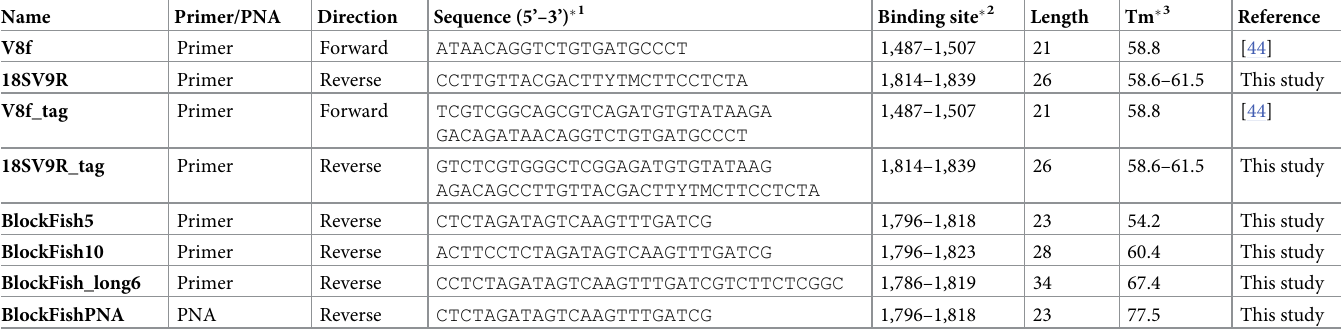
Preparation of fish genomic DNA, PCR condition, and DNA sequencing The dorsal fins or dorsal muscles of the fish samples were cut into sections (approximately 0.1 g each), which were transferred into separate 1.5 ml microcentrifuge tubes (Greiner Bio-One, Kremsmu¨nster, Austria). The genomic DNA of the fish samples was extracted using a DNeasy Plant Mini Kit (Qiagen, Hilden, Germany) according to the manufacturer’s protocol. The con- centration of genomic DNA of each sample was quantified using a Qubit 1 3.0 Fluorometer (Thermo Fisher Scientific, Waltham, MA, USA) according to the manufacturer’s protocol. The 18S ribosomal RNA gene V8–V9 region of the fish samples was amplified by PCR using universal primer V8f [44] (Table 1) and 18SV9R (Table 1). The PCR mixture was as follows: Table 1. List of the primers and the PNA clamp used in this study for